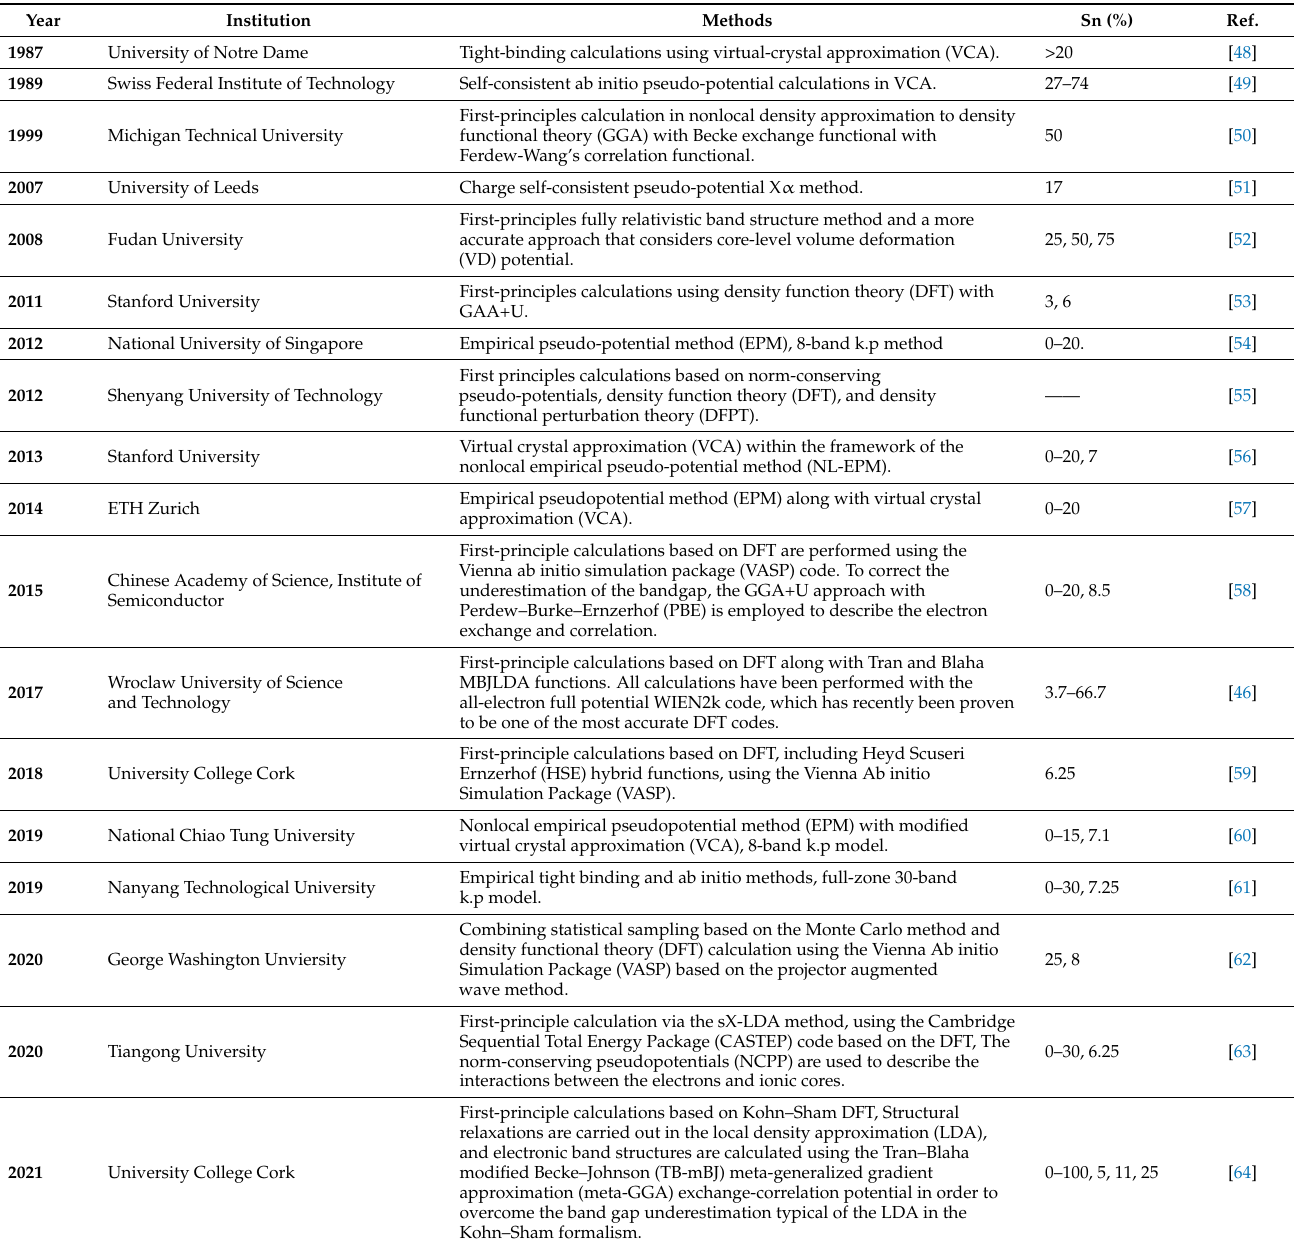
Table 1. Theoretical study on the material properties of direct bandgap GeSn in terms of institution, theoretical methods, and Sn